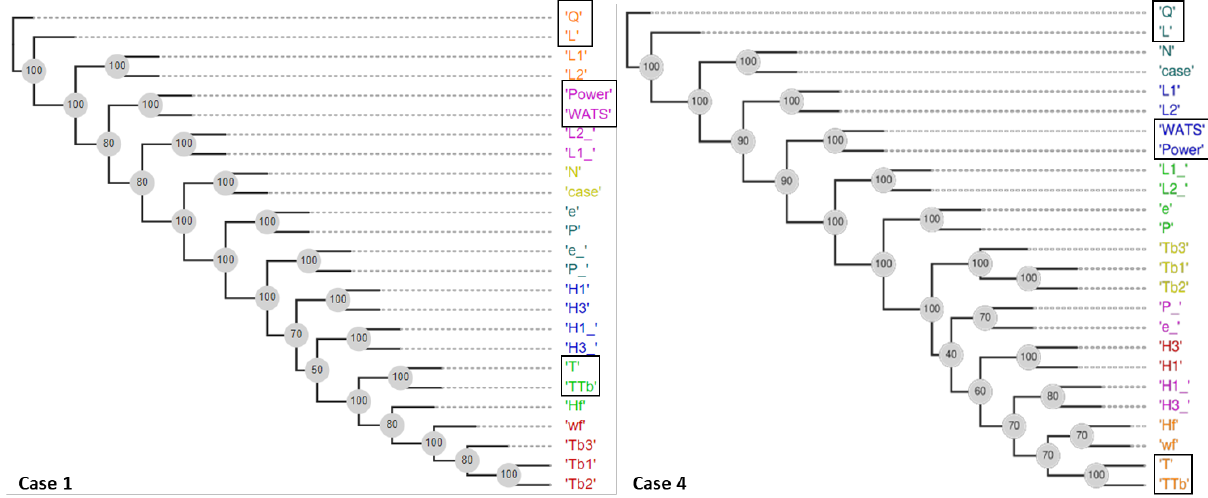
Figure 8. Phylograms for Cases 1 and 4 (Table 3). Table 5. Distances between the objectives for Case 1.